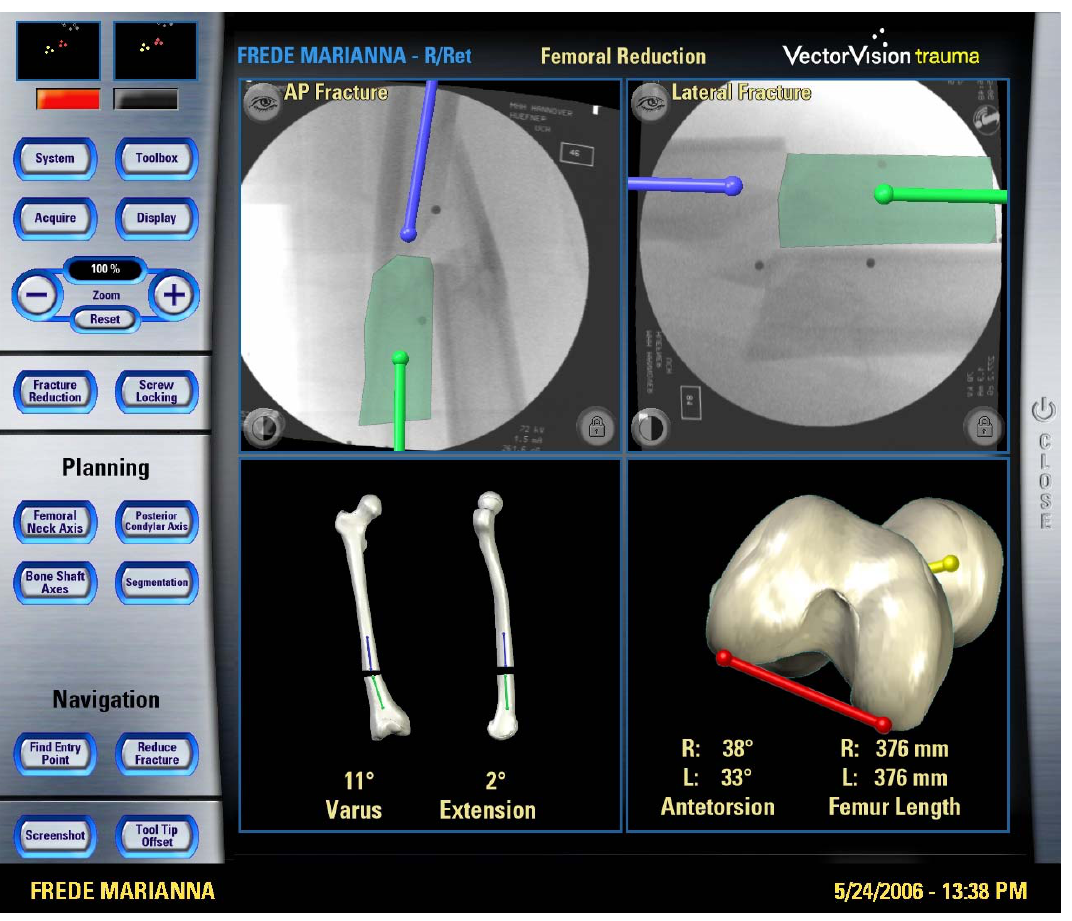
Fig. 1 Navigation screen of a femoral fracture reduction and anteversion module. The acquired fluoroscopic images allow for the dynamic visualization of the reduction process in ap and lateral positions without further intraoperatve radiation (upper two images). Further control of femoral anteversion can be achieved bilaterally while comparing the injured to the uninjured site (lower right